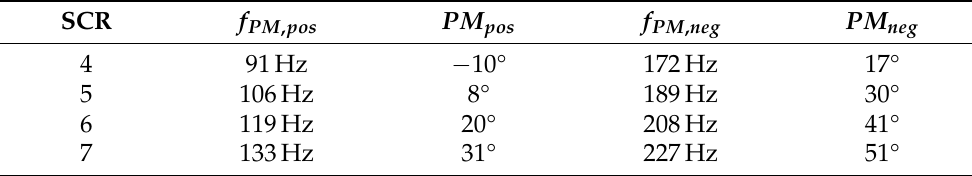
Figure 9. Close up of MMC and AC grid impedance intersections for ( a ) positive-sequence and ( b ) negative-sequence impedances. Table 3. Phase Margins for positive- and negative-sequence